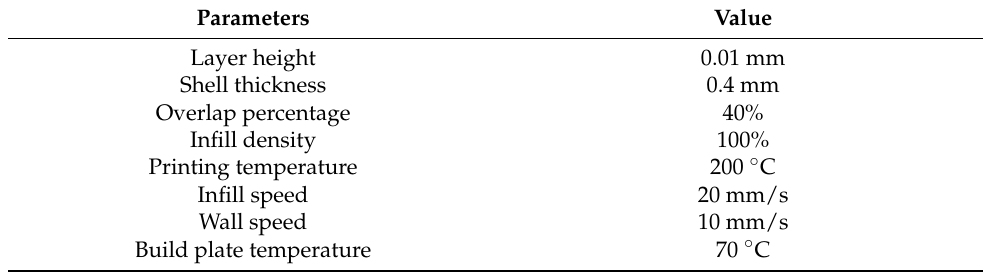
Table 1. FDM parameters.